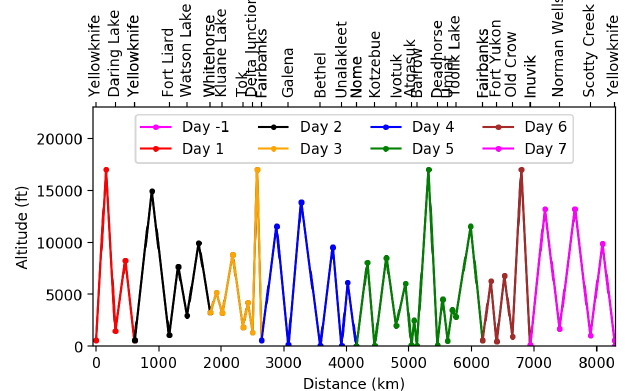
Figure 3. Locations and maximum altitudes of the 25 vertical pro- files that were acquired during each Arctic-CAP campaign. The col- ors match the flight lines illustrated in Fig.